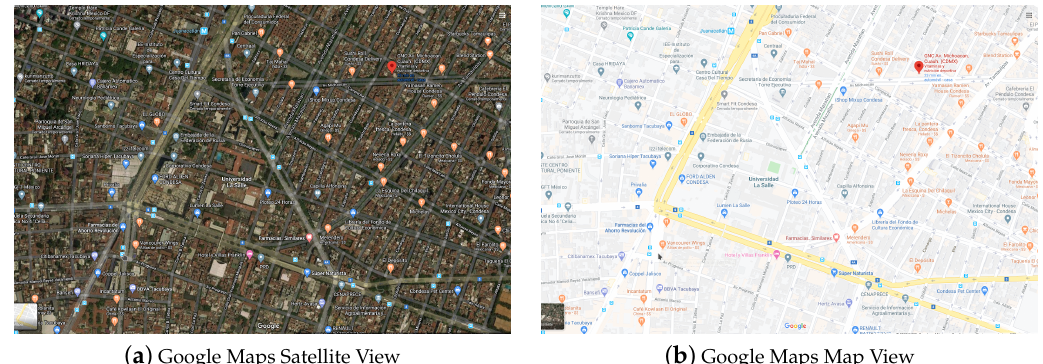
Figure 2. Study area, “Av. Insurgentes” Street in Mexico City.